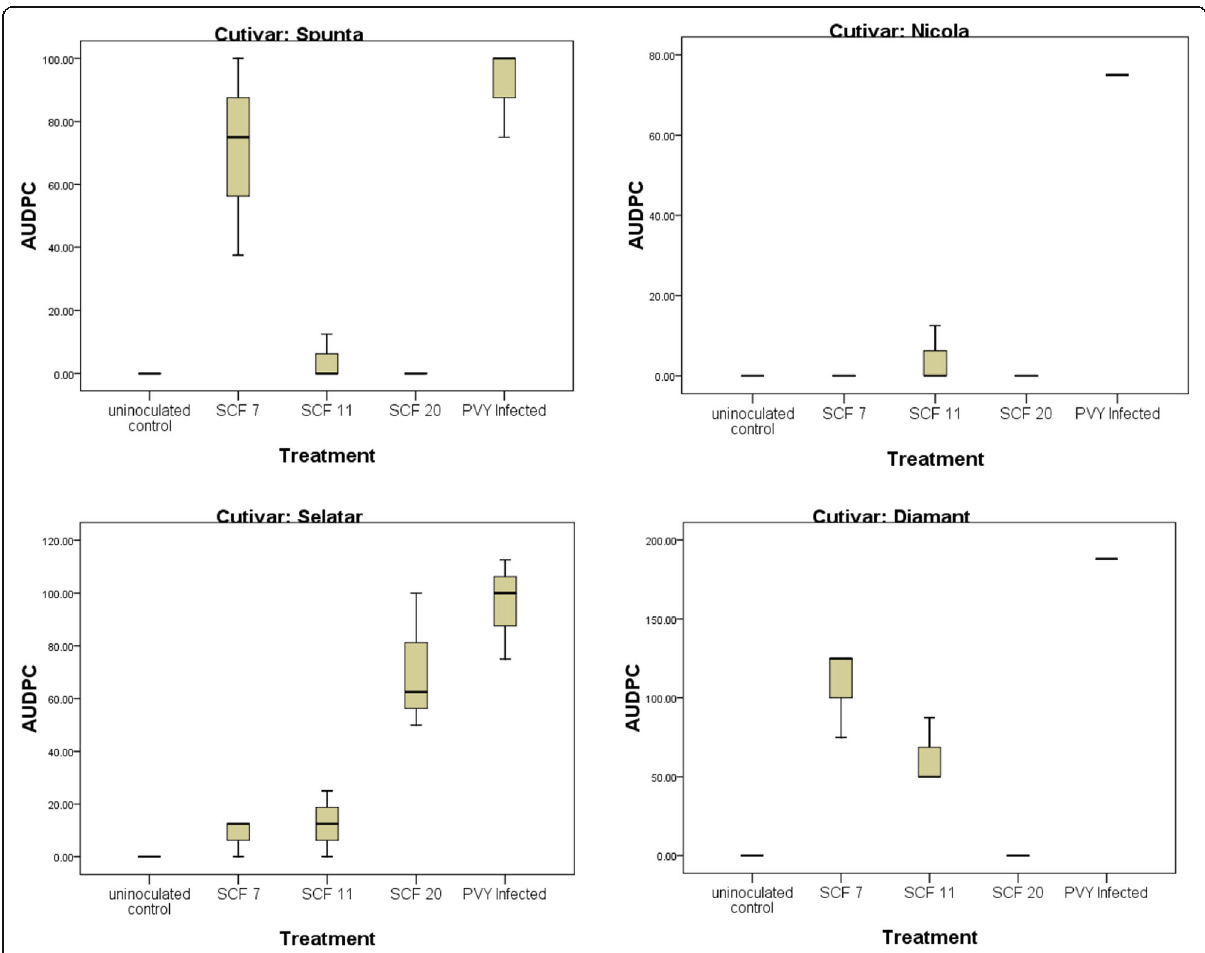
Fig. 1 Influence of foliar spraying of SCF7, SCF11, and SCF20 on AUDPC of PVY NTN in four potato cvs. The actinomycetes ’ filtrates were applied before and post virus inoculation. Variation in data shown by boxplot histogram (SPSS17). Streptomyces netropsis DSM 40093 (SCF7), Streptomyces ambofaciens (SCF11), and Streptomyces actuosus (SCF20). The disease was most severe for Diamant, less severe for Selatar, Spunta, and least for Nicola. AUDPC area under disease progress